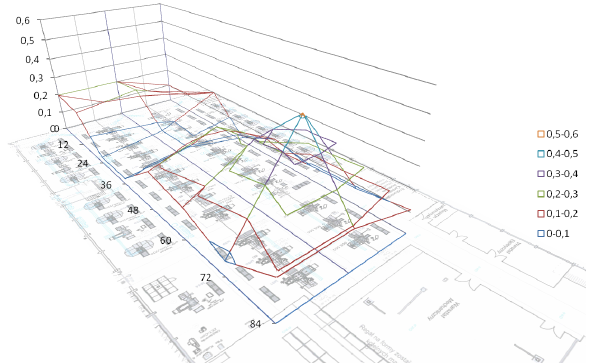
Figure 6: Air temperature in Hall1 at a height of 6